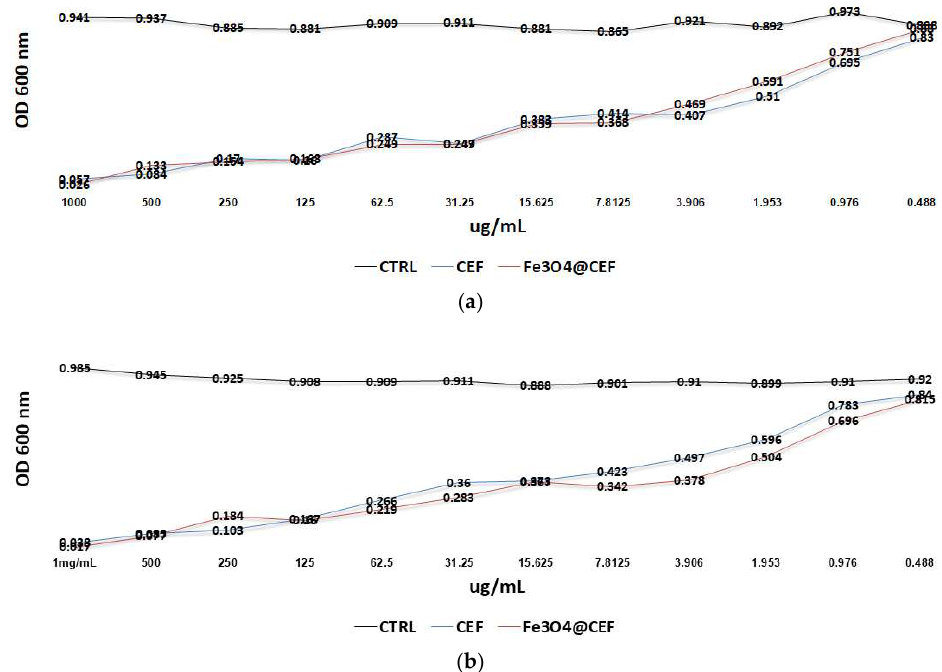
Figure 4. Graphic representation of E. coli ( a ) and S. aureus ( b ) growth for 24 h in the presence of different concentrations of plain Cefepime hydrochloride (CEF) and nanosystem embedded cefepime hydrochloride (Fe 3 O 4 @CEF).